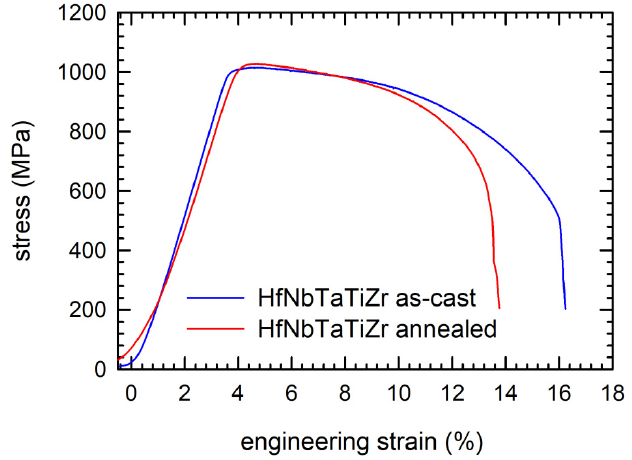
Figure 22. Stress–strain curves of HfNbTaTiZr alloy subjected to tensile deformation at room temperature with the strain of 10 − 3 s − 1 . Results for the as-cast HfNbTaTiZr alloy (blue curve) and the alloy annealed at 1200 °C (red curve) are compared.